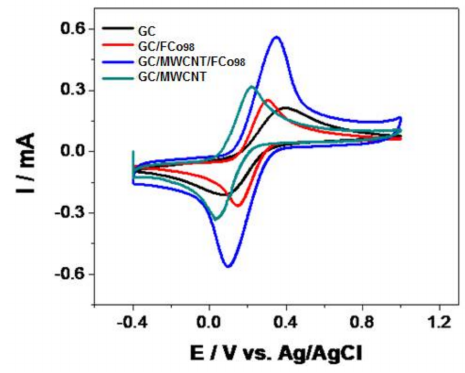
Figure 3. Cyclic voltammograms for potassium ferrocyanide/potassium ferricyanide 0.01 mol L − 1 in phosphate buffer 0.1 mol L − 1 (pH = 7) with a scan rate of 100 mV s − 1 of GC (——), GC/ FCo 98 (——), GC/MWCNT (——), GC/MWCNT/FCo 98